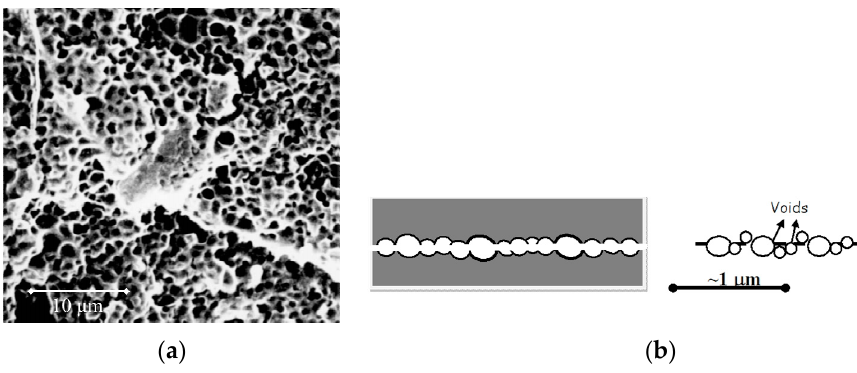
Figure 14. The fracture of the steel containing a higher than 15% void swelling at temperature T t ≈ T ir : ( a ) 18Cr-10Ni-Ti ASS irradiated at BOR-60 to 72 dpa with 26% void swelling; after tensile test at 450–550 °C. Reproduced from [35] with courtesy of V. S. Neustroev. Elsevier reuse license has been granted. ( b ) Scheme of the fracture mechanism emphasizing that the void boundaries are deformed by creep and linked up.